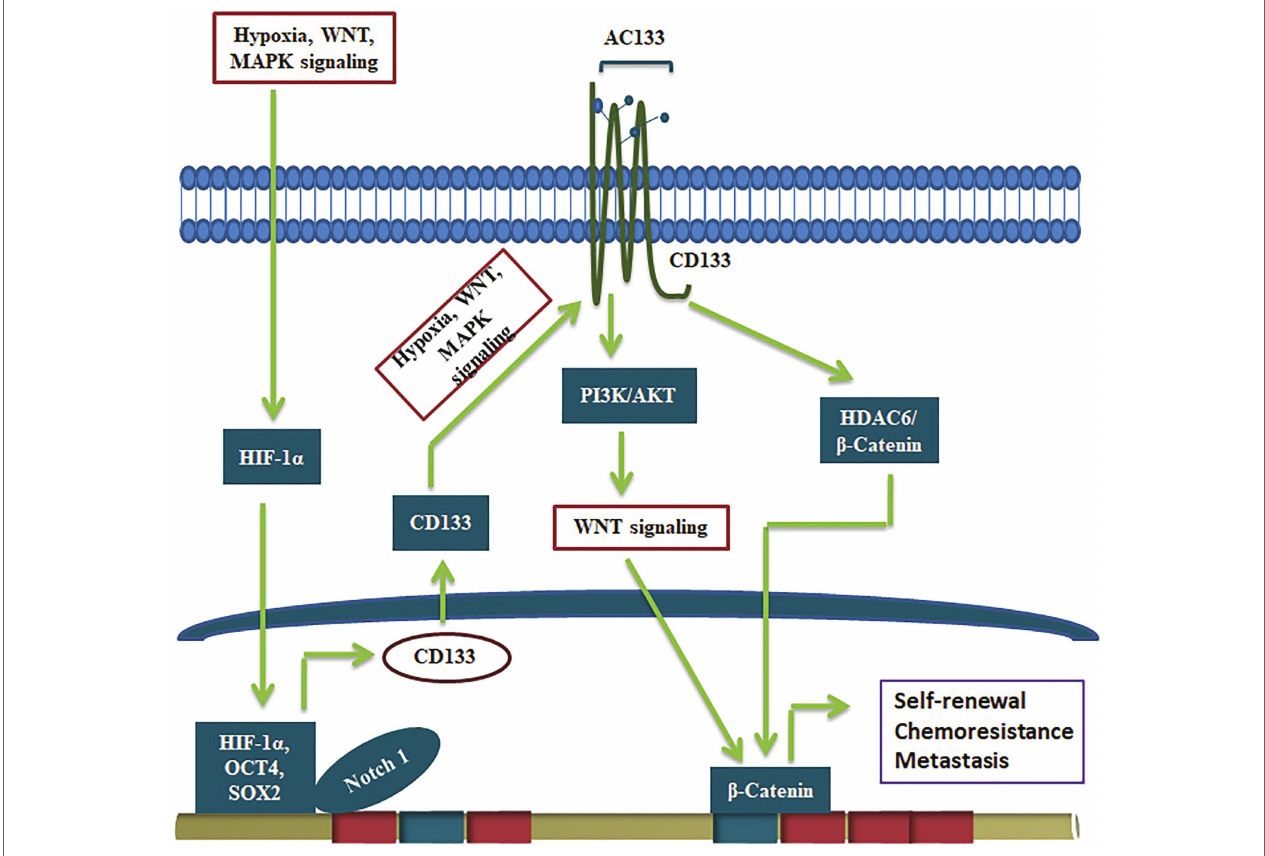
FIGURE 3 | CD133 in the regulation of CSCs. The expression of CD133 and its conversion to active form containing AC133 epitope by glycosylation is regulated by upstream signals like hypoxia and pathways like MAPK and WNT. The active CD133 primarily regulate WNT/ β -catenin pathway to drive